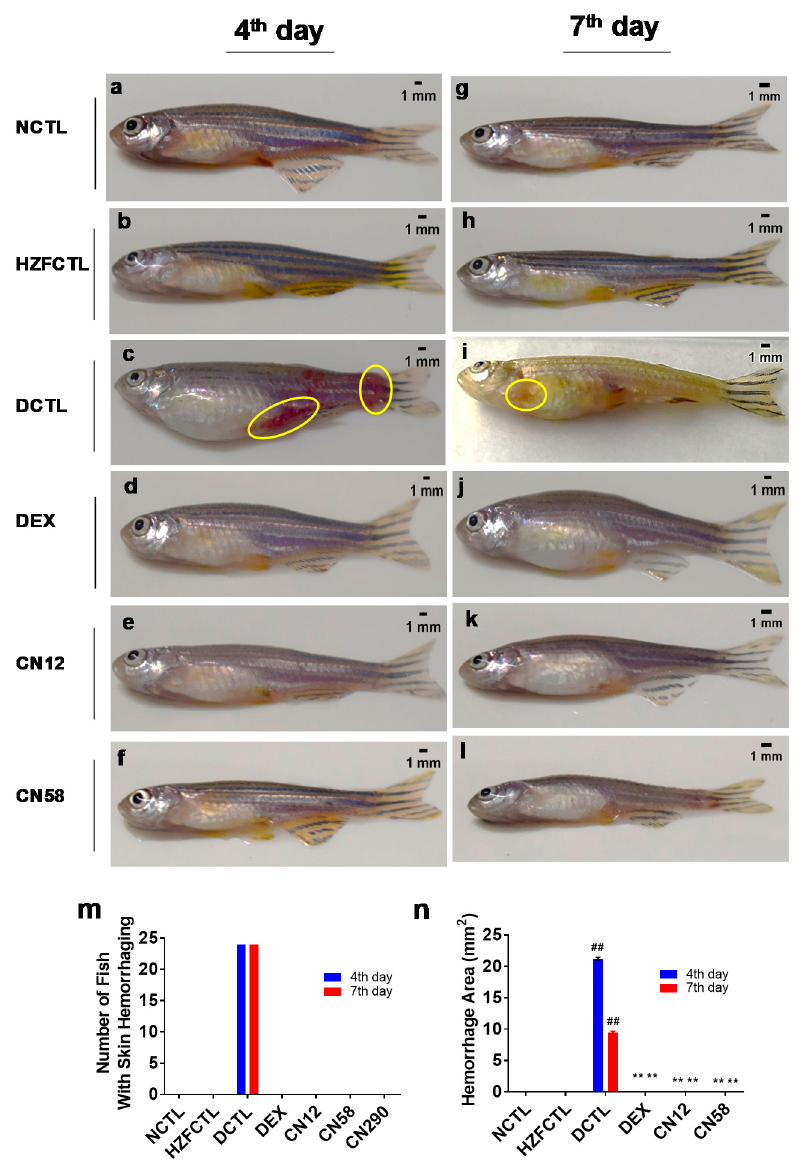
Figure 8. Pharmacological treatment with Coronil inhibits SARS-CoV-2 spike protein induced hemorrhage. Zebrafish were euthanized at end of study and whole animal imaging was